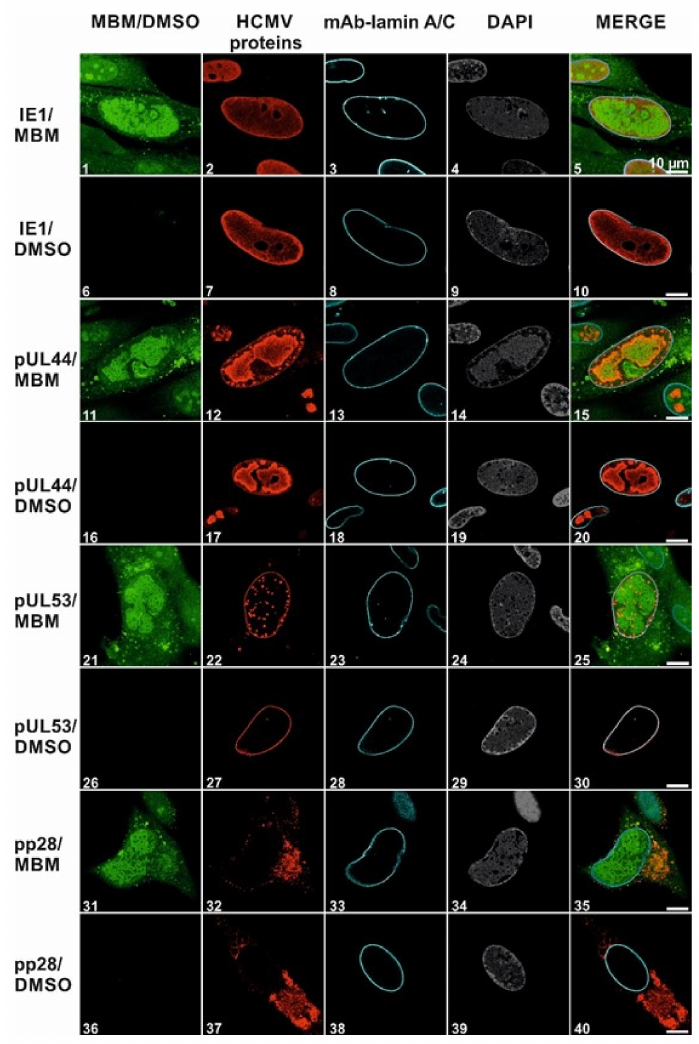
Figure 6. Merbromin does not interfere with the localization of viral proteins other than the core NEC complex in HCMV-infected HFFs: confocal imaging (indirect immunofluorescence staining) of the intracellular localization of representative HCMV proteins (immediate early, IE1; early, pUL44 and pUL53; late, pp28) and cellular lamin A/C in the presence of merbromin (5 µ M). Counterstainings of the autofluorescent merbromin and the nuclei (DAPI), as well as a merge of all signals (right column) are shown. Scale bars indicate 10 µ m. See Section 2.6 for experimental